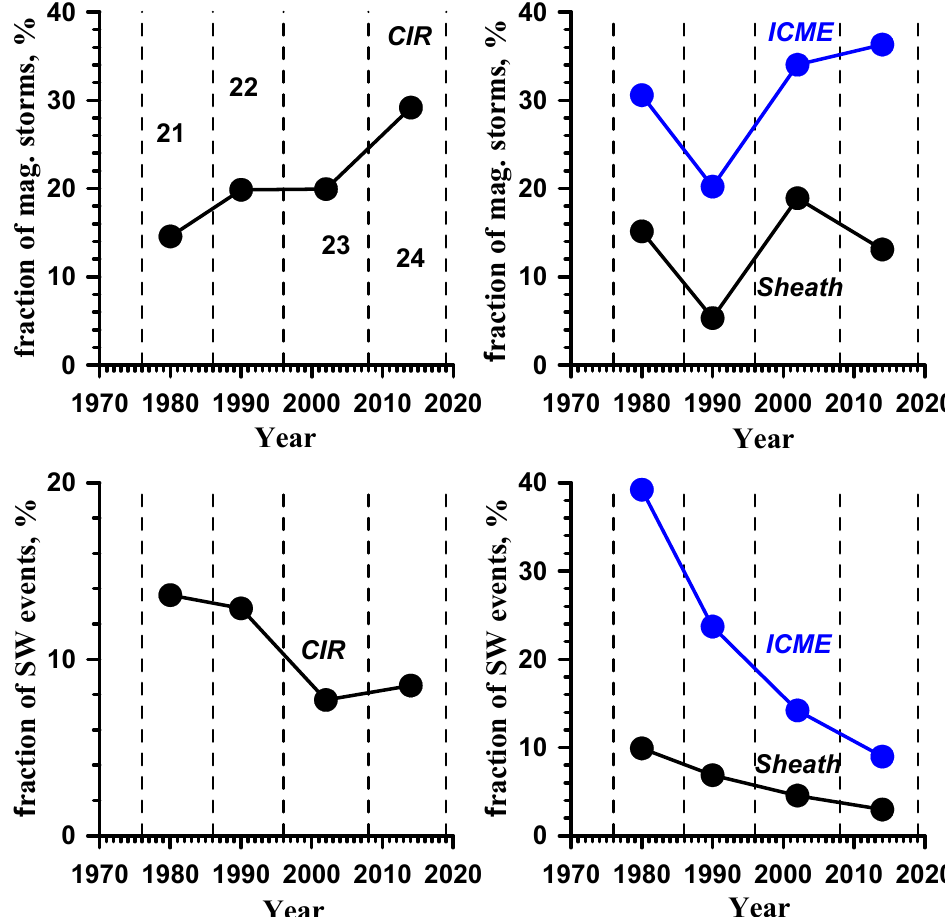
Figure 2. Temporal profiles of fraction of magnetic storms (upper panels) and fraction of SW events (bottom panels) during solar cycles 21–24: for CIRs (left panels), sheaths (right panels, black circles) and ICMEs (right panels, blue circles).